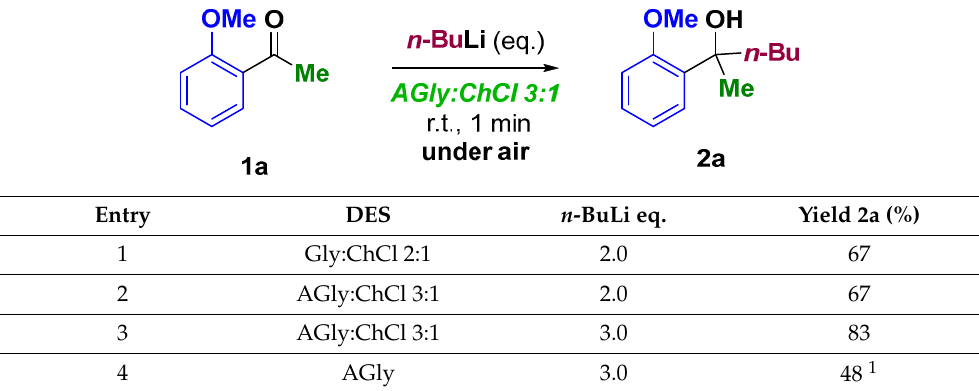
Table 2. Screening of the reaction conditions for the n -BuLi addition to model substrate 1a.